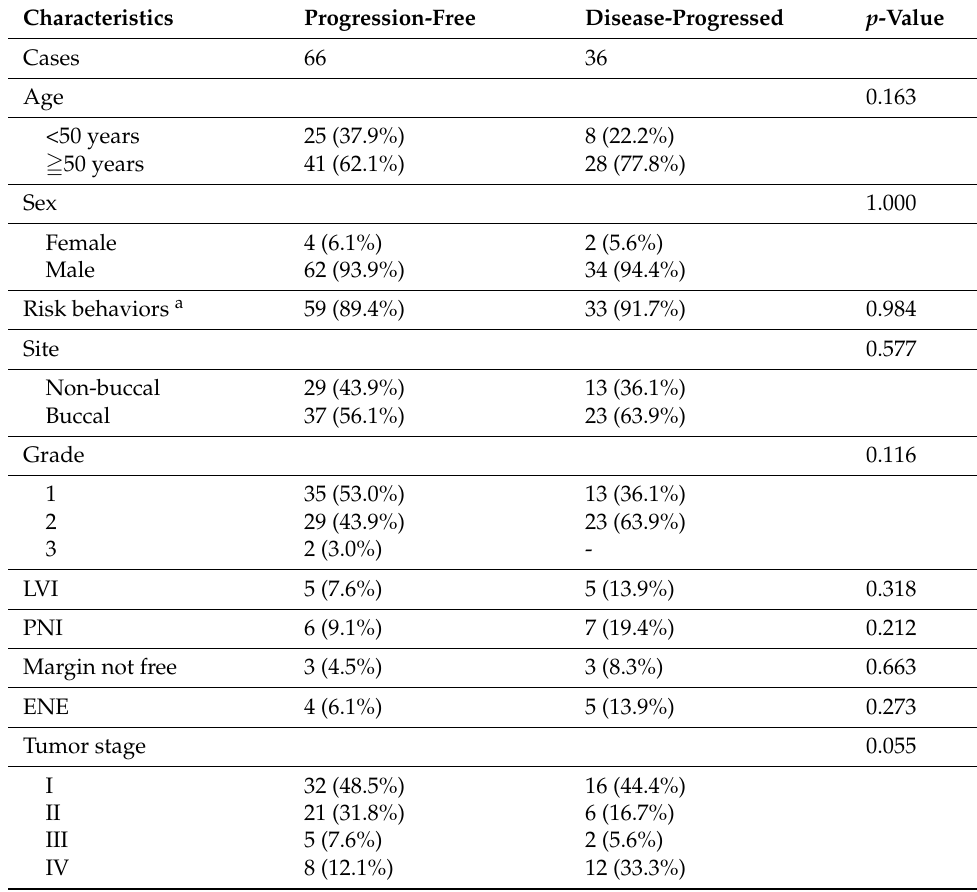
Table 2. Baseline characteristics of study population according to progression-free survival status.